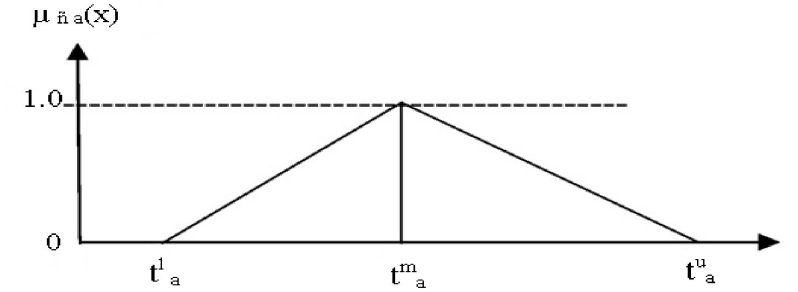
Figure 5. Membership Function of Triangular Fuzzy